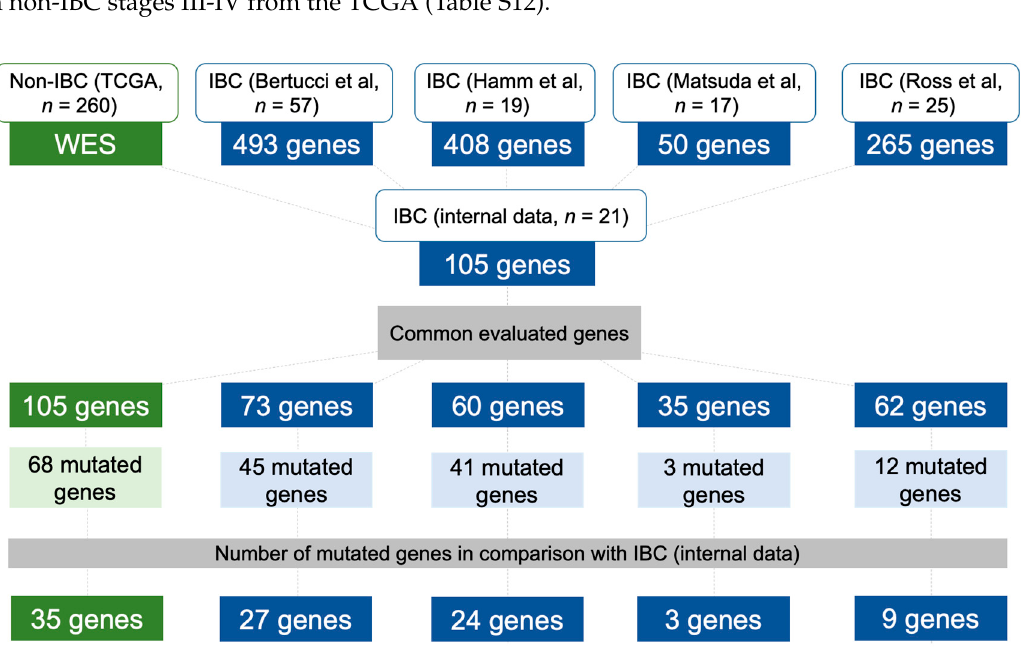
Figure 4. Diagram showing the datasets used to compare the mutational profile of non-IBC and IBC cases with our IBC patients. The total number of genes evaluated by each study, the number of genes in common in relation to our study, the mutated genes per study, and the number of common mutated genes compared to our cases are depicted. WES: whole-exome sequencing.